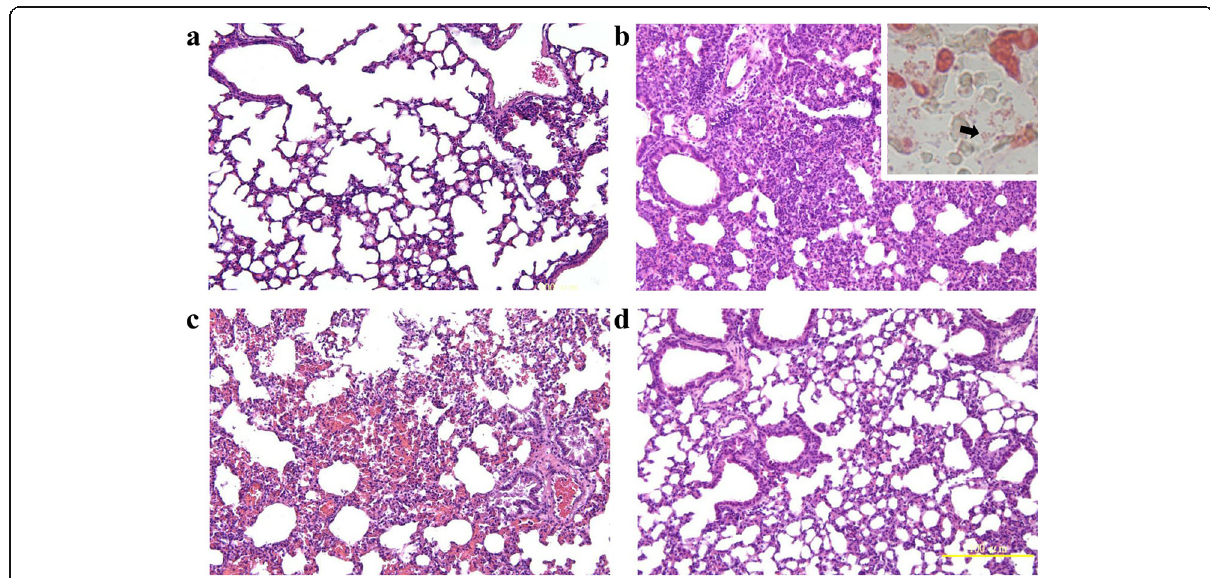
Fig. 4 Pathological pulmonary findings after intratracheal inoculation of KM18. Uninfected mice (a, H&E, × 100), control group mice (b, H&E, × 100) and diplococci (arrowhead) in an alveolar sac with Gram staining (right upper panel of b, × 1000), colistin treatment group mice (c, H&E, ×